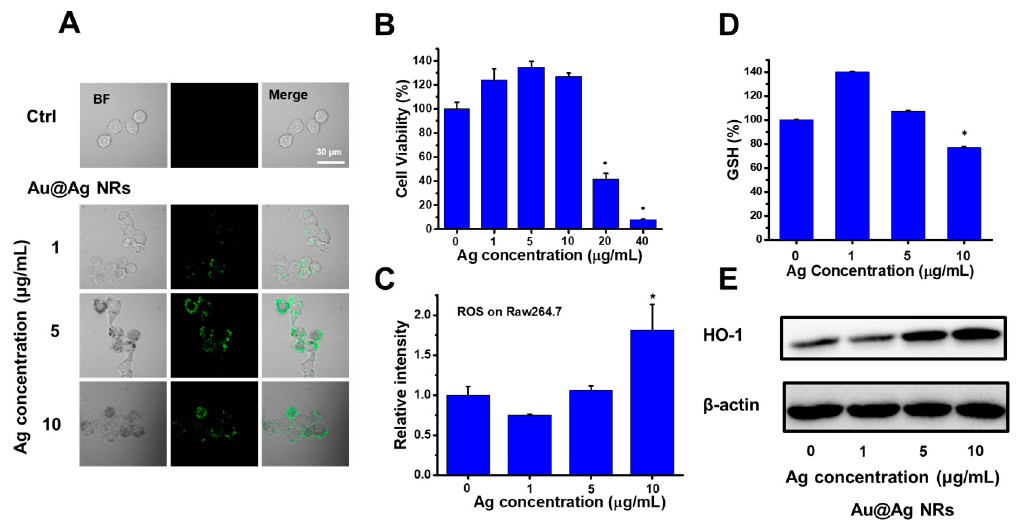
Figure 4. Effects of Au@Ag NRs on Raw264.7 cells. ( A ) in vitro two-photon luminescence (TPL) images upon different Au@Ag NR exposure concentrations; ( B ) cell viability of Raw264.7 cells affected by Au@Ag NRs; ( C ) folds of fluorescent intensity detected with 2 ′ ,7 ′ -Dichlorofluorescin diacetate (DCFH-DA) by flow cytometry; ( D ) relative level of reduced glutathione (GSH) after the treatment with Au@Ag for 24 h; ( E ) Western blotting results of HO-1, after exposed to Au@Ag NRs for 24 h. The * represents significant difference from control group (*: p < 0.05). The data were presented as mean ± SD ( n = 3).